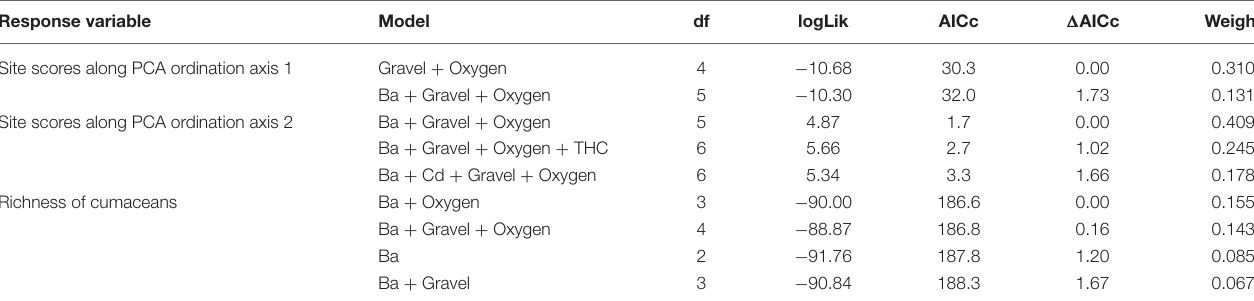
TABLE 5 | Most supported ( 1 AIC < 2) models testing for impacts of environmental factors on species composition (site scores along PCA ordination axes 1 and 2, linear regression) and richness of cumaceans (generalized linear model with Poisson distribution). Response